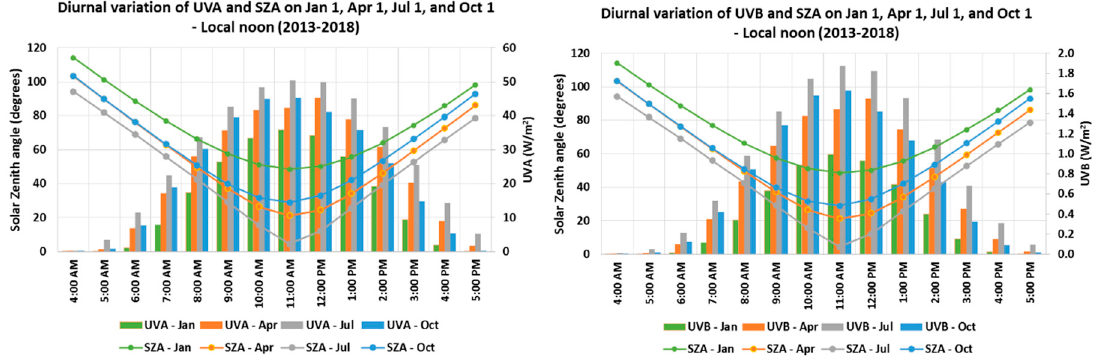
Figure 6. Monthly variation of ( left ) UVA and ( right ) UVB with relative humidity (a gauge of atmospheric water vapor content) at local noon in Doha, Qatar from 2013 to 2018.